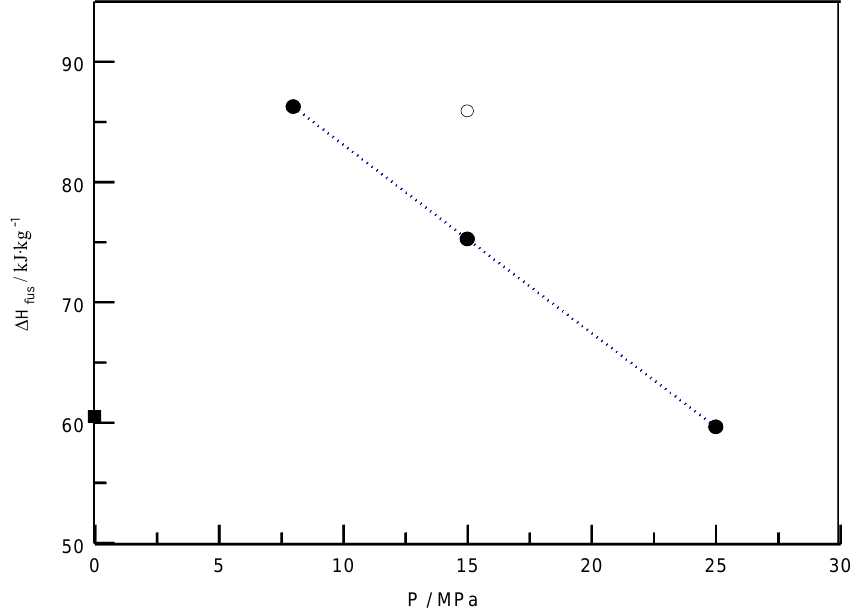
Fig.19.AXG Figure 18. Effect of pressure and temperature on the heat of fusion of the PP 75%/EPTSR 25% polymer blend at various operation parameters of the SEDS process. (cid:4) —melt blending (conventional method). —produced by SEDS method at 60 ◦ C. (cid:35)